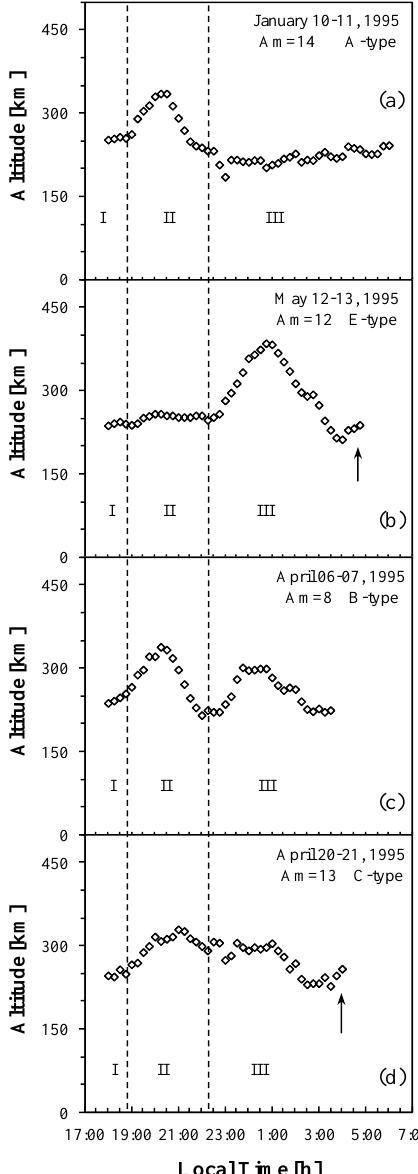
Figure 1. Typical F-layer height variations as a function of LT time observed throughout the whole solar minimum period 1995–1997 at Korhogo. The vertical dashed lines divide the night-time pat- terns into three main parts (I, II, III), each associated with a specific mechanism: (a) the A-type pattern characterized by a single height peak in phase II associated with the well-known evening upward E × B drift; (b) the E-type pattern characterized by a single height peak in phase III in the midnight sector; (c) the B-type pattern re- grouping the A- and E-type patterns; (d) the C-type pattern with a single height peak characterized by a steady state. The upward ar- rows in phase III of panels (b) and (d) indicate another elevation motion of the F layer probably due to pre-sunrise phenomena.